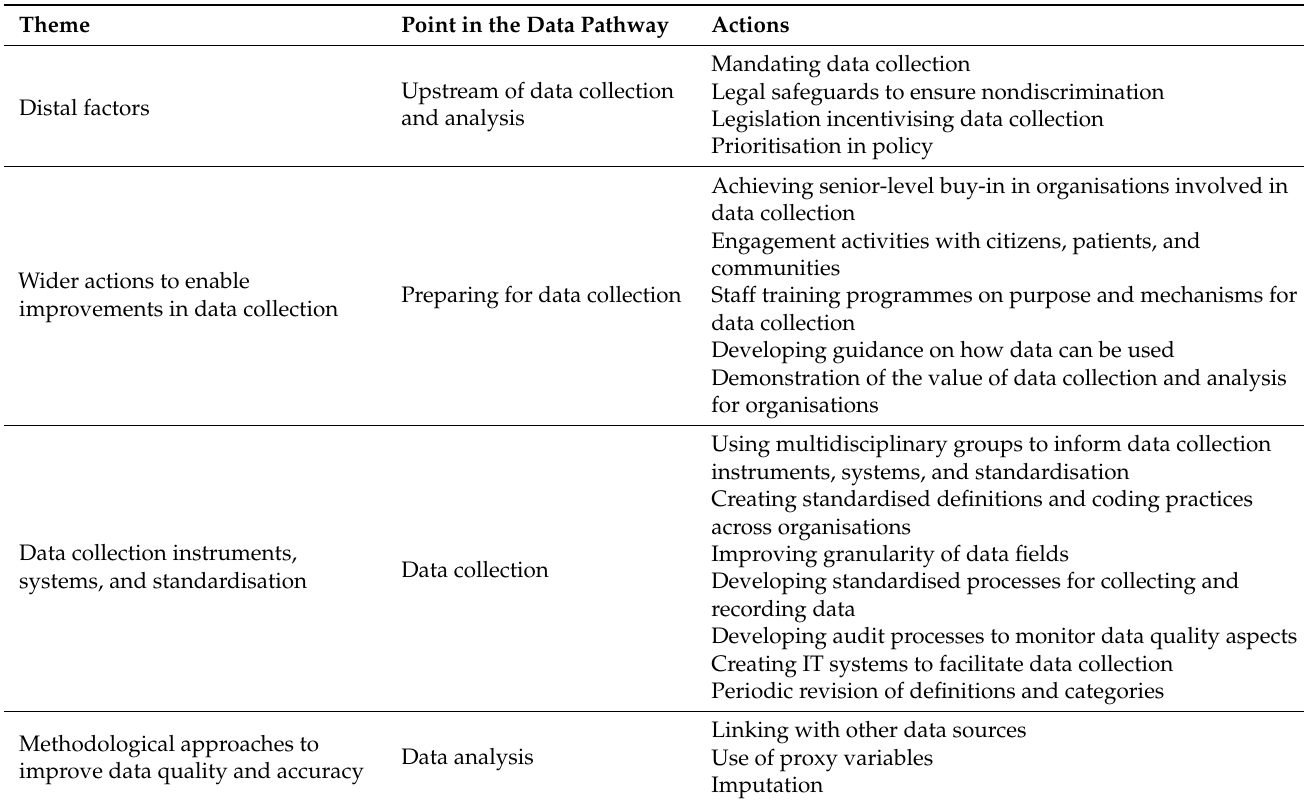
Table 2. Summary of best